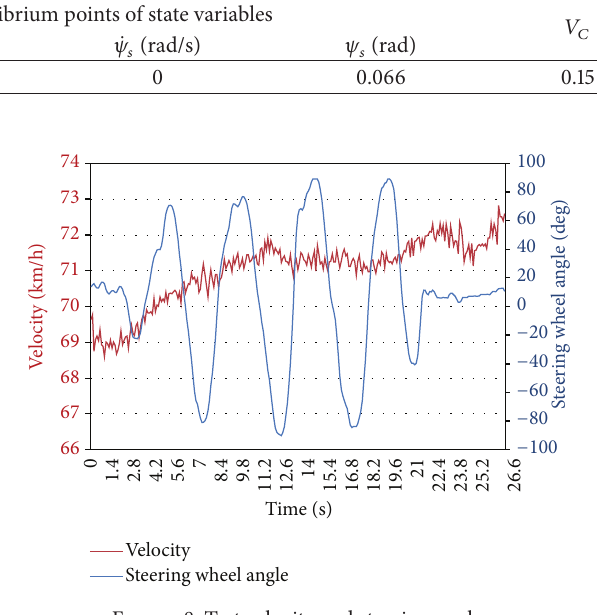
Figure 8: Test velocity and steering angle.